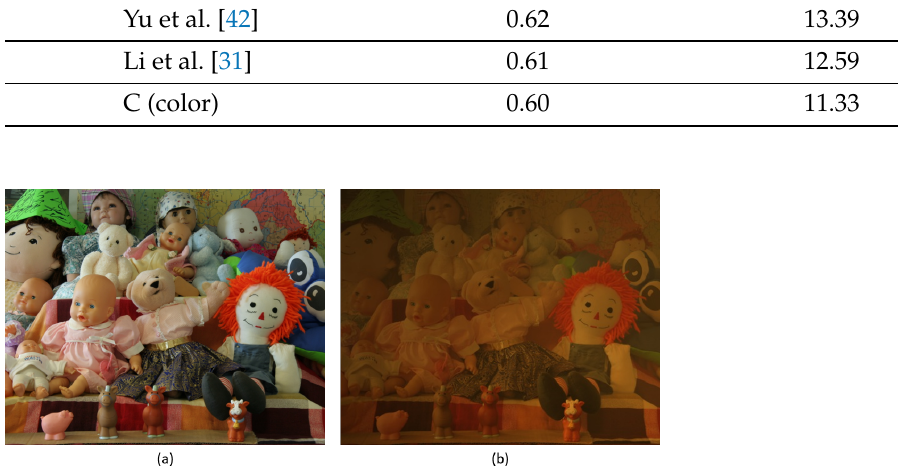
Figure 19. Image from the Middlebury dataset [44]: ( a ) input image, ( b ) nighttime synthetic im- age [43]. In the context of synthetic images, the size of the opening filter is set to (30,30) instead of